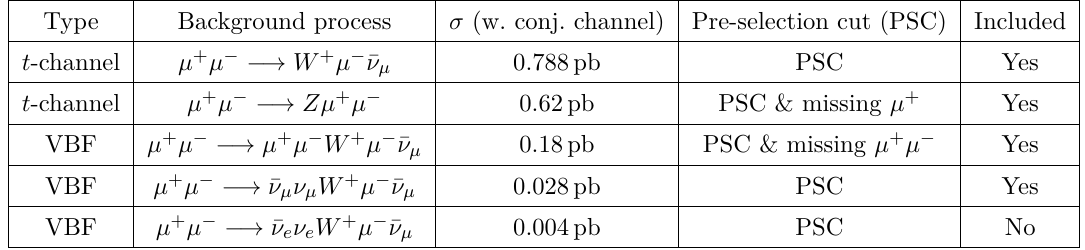
Table 2 . N µ background at 3 TeV. The cross section includes the charge conjugate